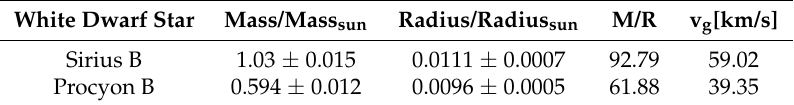
Table 2. Sirius B and Procyon B masses and radii [46], M/R ratio, and computed gravitational redshifts using Equation